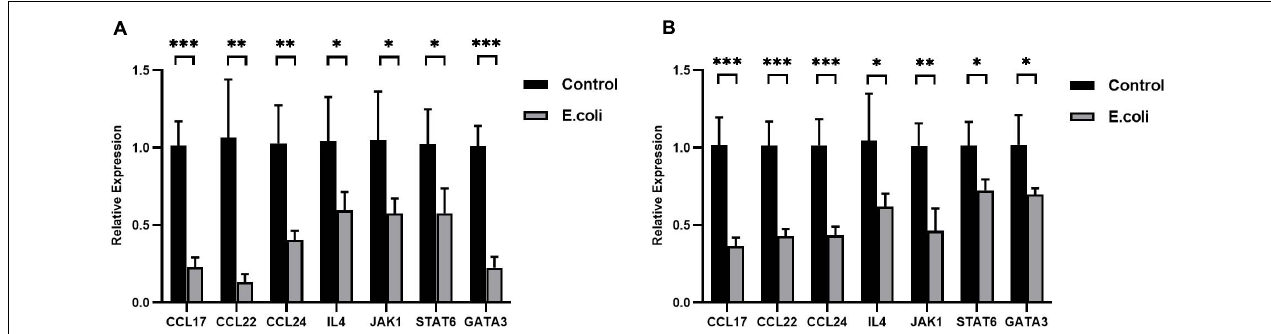
FIGURE 5 | Expression of the IL-4/JAK-1/STAT-6 pathway in mice with aerobic vaginitis induced by E. coli infection. (A) Relative expression of the IL-4/JAK-1/STAT-6 pathway in the placenta of mice infected by E. coli at E11.5. (B) Relative expression of the IL-4/JAK-1/STAT-6 pathway in the uterus of mice infected by E. coli at E11.5. Four samples of each group were used. The experiment was performed in triplicate wells and repeated three times. Data are shown as mean ± standard deviation. Unpaired t -test was used for two-group comparisons. ∗ P < 0.05, ∗∗ P < 0.01, ∗∗∗ P < 0.001.